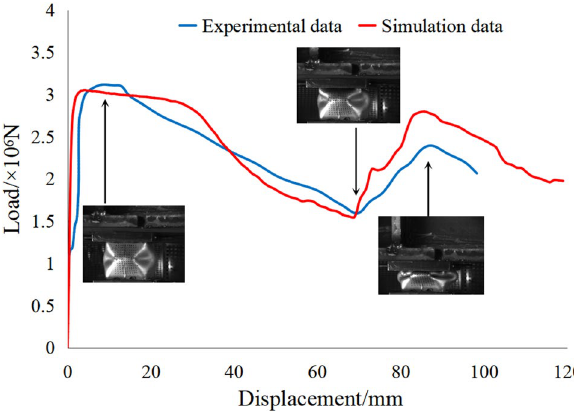
Figure 7. The load displacement curve of test and simulation.